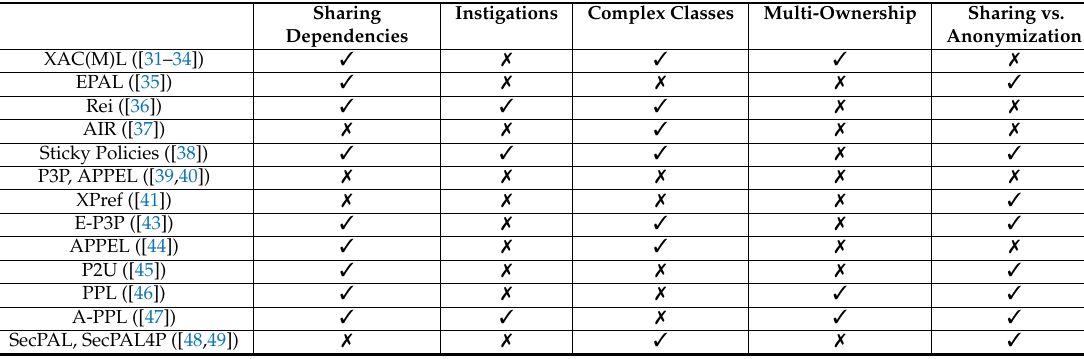
Table 3. Privacy languages against health data sharing